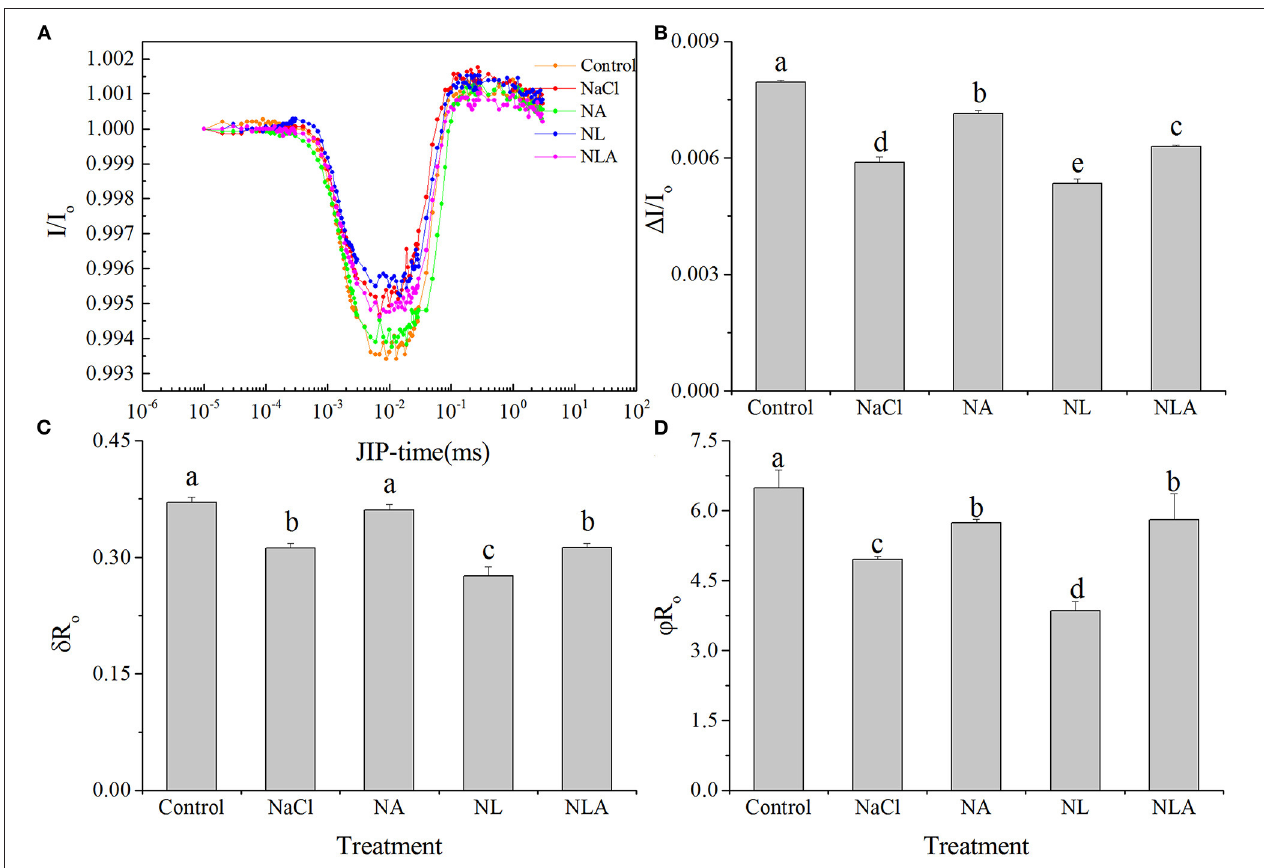
FIGURE 12 | Curves of light induced modulated 820nm reflection ( I / I o ) kinetics (A) and maximal redox capacity of PSI ( 1 I / I o ) (B) , efficiency with which an electron from the intersystem electron carriers is transferred to reduce end electron acceptors at the PSI acceptor side ( δ R o ) (C) , and quantum yield for reduction of end electron acceptors at the PSI acceptor side ( φ R o ) (D) in the leaves of salt-stressed tomato seedling with or without exogenous ascorbic acid (AsA) and lycorine (LYC) spraying. Values are means ± SD ( n = 3). Different letters (a, b, c, d, and e) indicate significant difference at P < 0.05 among treatments. Error bar is smaller than the line at the top of the graph. Control, no added NaCl, no sprayed AsA and LYC; NaCl, added 100 mmol/L NaCl; NA, added 100 mmol/L NaCl and sprayed 0.5 mmol/L AsA; NL, added 100 mmol/L NaCl and sprayed 0.25 mmol/L LYC; NLA, added 100 mmol/L NaCl and sprayed 0.25 mmol/L LYC and 0.5